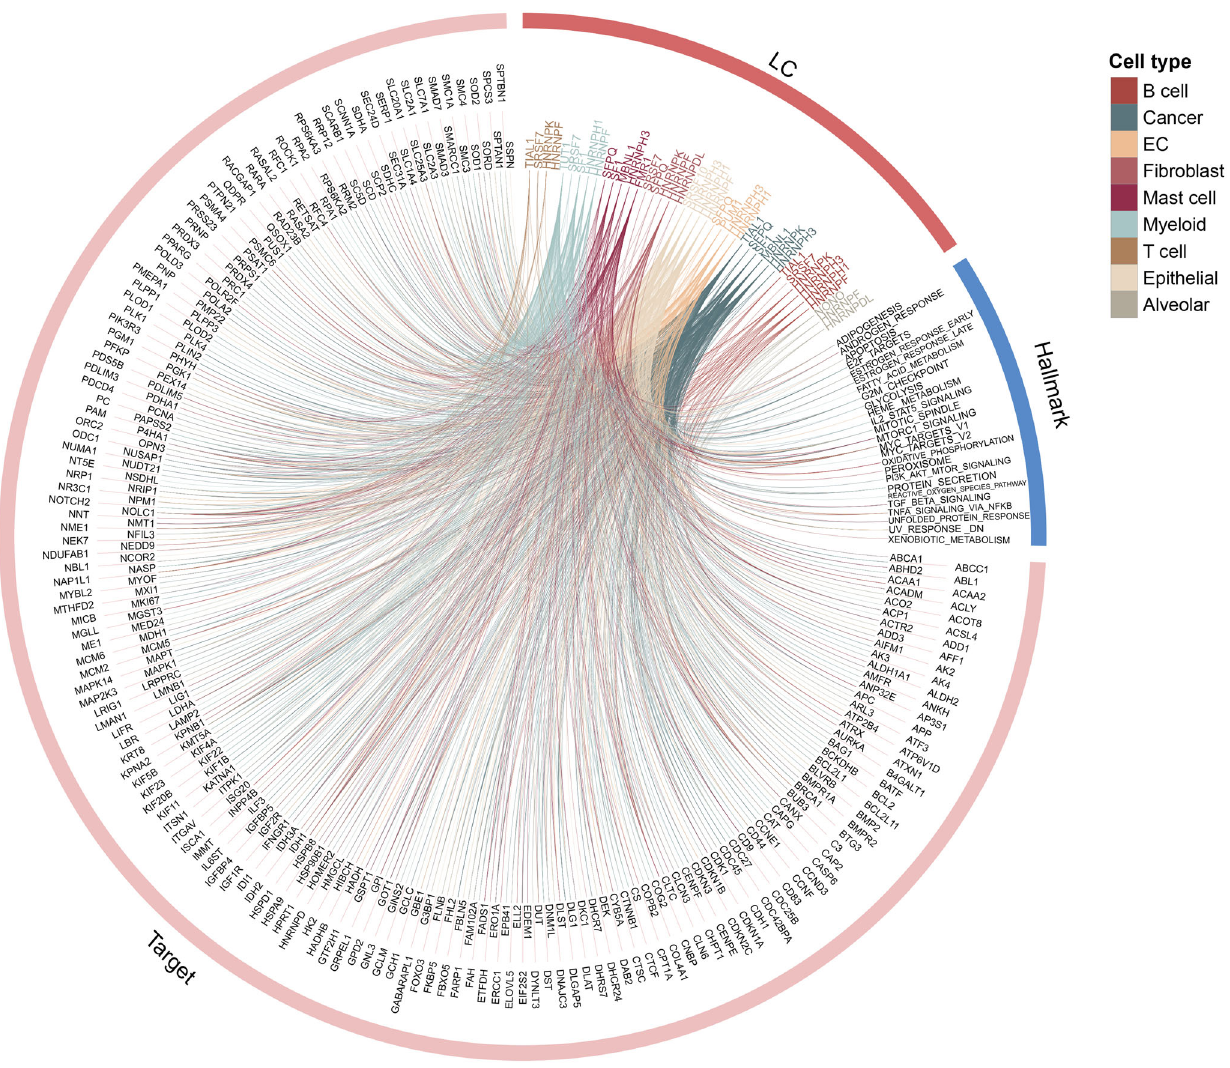
Fig. 5 Circos plot for functions of RBP regulators in lung cancer. RBPs and genes were linked if the genes were potential targets of corresponding RBPs. Genes annotated to cancer hallmarks were linked to corresponding pathways. Lines were colored by cancer types. The colors of RBP gene names indicated in which cell type the RBP was identi fi